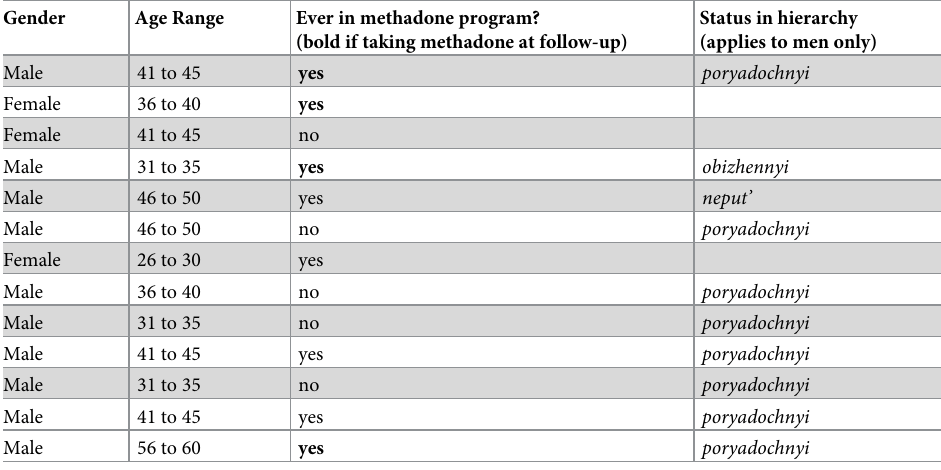
Table 2. Qualitative interview participant